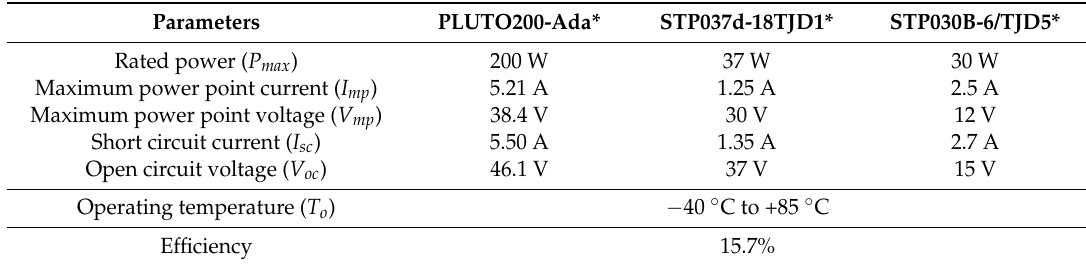
Table 2. Three main types of photovoltaic (PV) panel data sheet.